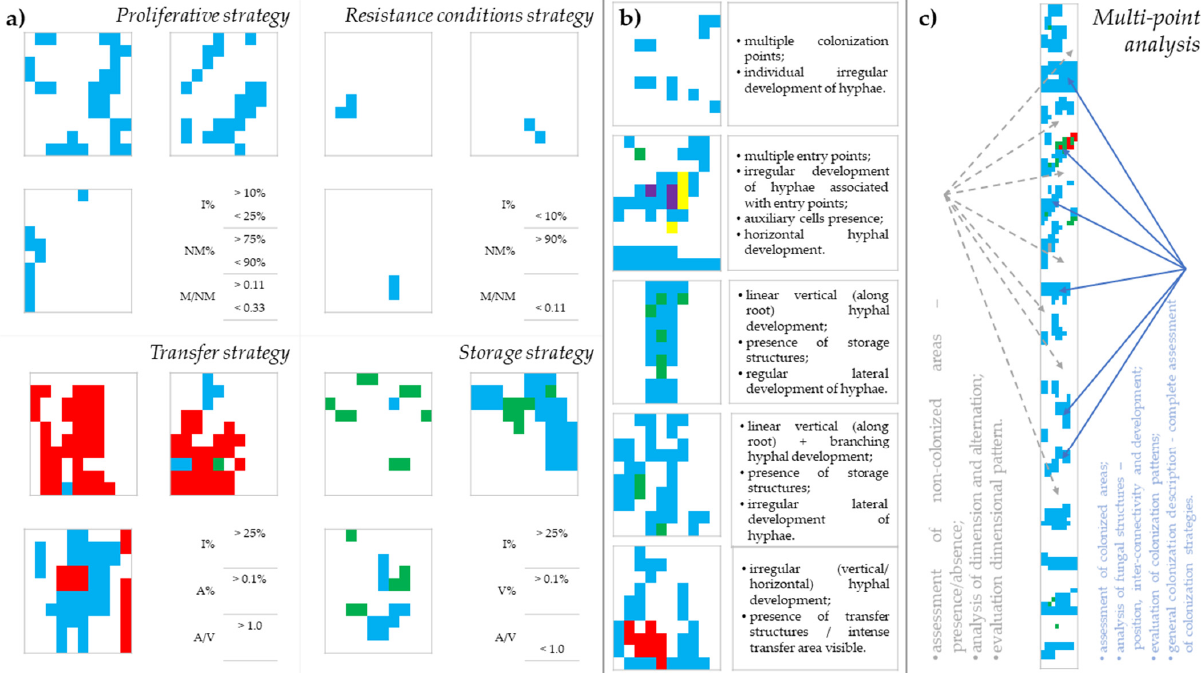
Figure 3. Assemblage of multi-point analysis characteristics as a guide to arbuscular mycorrhiza colonization patterns and strategies: ( a ) the threshold values of mycorrhizal parameters in relevant patterns of colonization strategies; ( b ) detailed mycorrhizal structure development; ( c ) establish- ment of multi-point analysis as a merging guide to mycorrhizal maps. Legend: I%—colonization intensity; NM%—non-mycorrhizal areas; M/NM—mycorrhizal/non-mycorrhizal areas report; A%— arbuscules abundance; V—vesicles abundance; A/V—arbuscules/Vesicles report. Square color in mycorrhizal maps: hyphae—blue; arbuscules—red; vesicles—green; auxiliary cells—yellow; entry points—purple (based on original color code